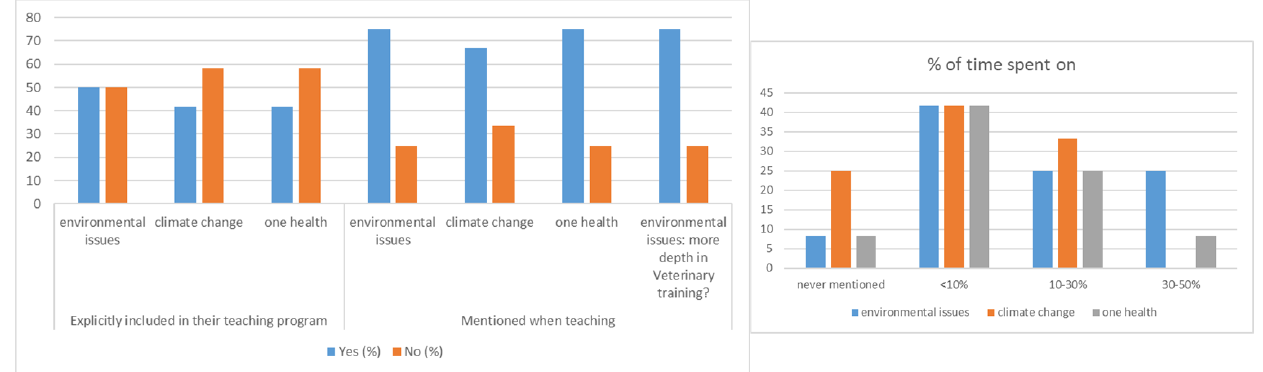
Figure 1. Environmental issues, climate change, and One Health ( left ) and time (%) spent on teaching these issues ( right ), in veterinary studies in Veterinary Medicine Faculty ULPGC.